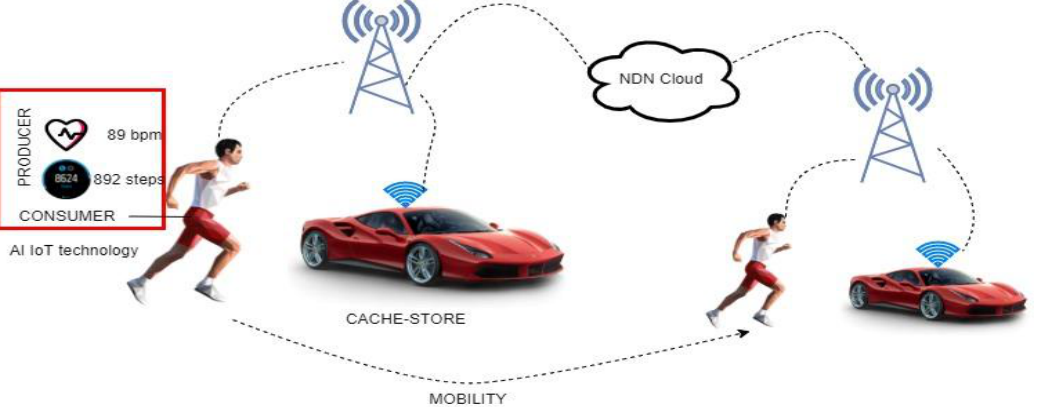
Figure 3. NDN AI mobility using smart technology.